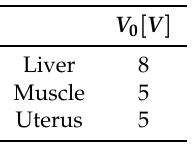
Table 4. Electrical potential used for the simulations.